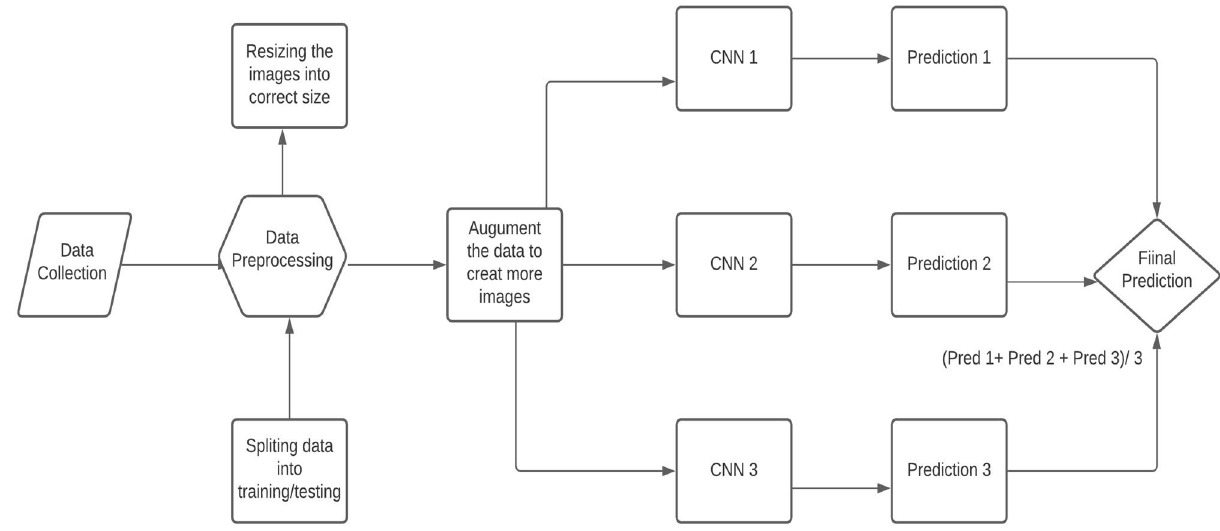
Figure 2. The architecture of the proposed methodology.